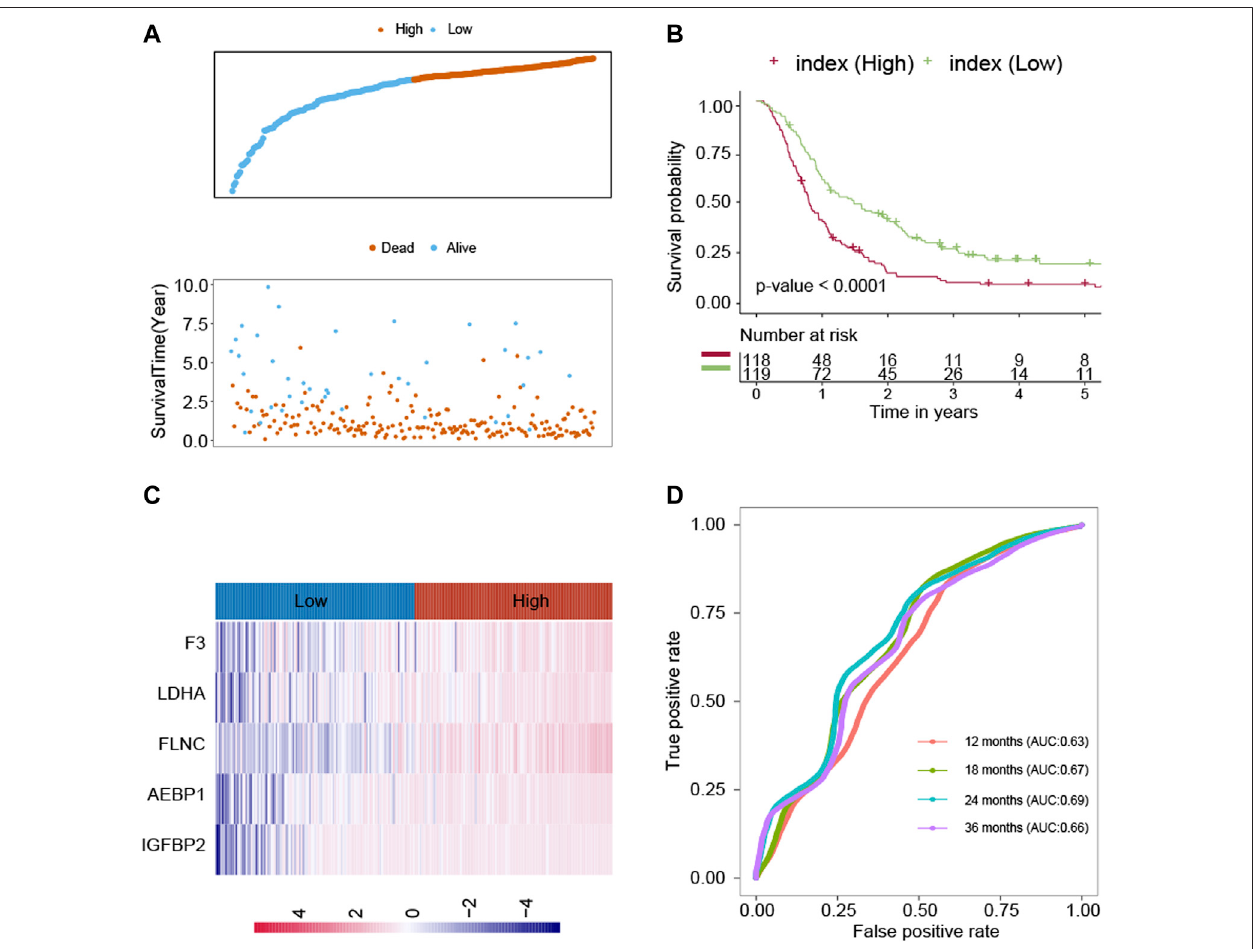
FIGURE 2 | Construction of the ECM index in the CGGA dataset. (A) ECM index distribution and overall survival status of the GBM patients. (B) Kaplan – Meier survivalcurvesofthehigh – andlow – ECMindexgroups. (C) Geneexpressionpro fi lesofECMgenesinthehigh – andlow – ECMindexgroups. (D) AUCvaluesfor12-,18-, 24-, and 36-month overall survival predictions for the ECM index. Extracellular Matrix (ECM); Glioblastomas (GBM); area under the curve (AUC).